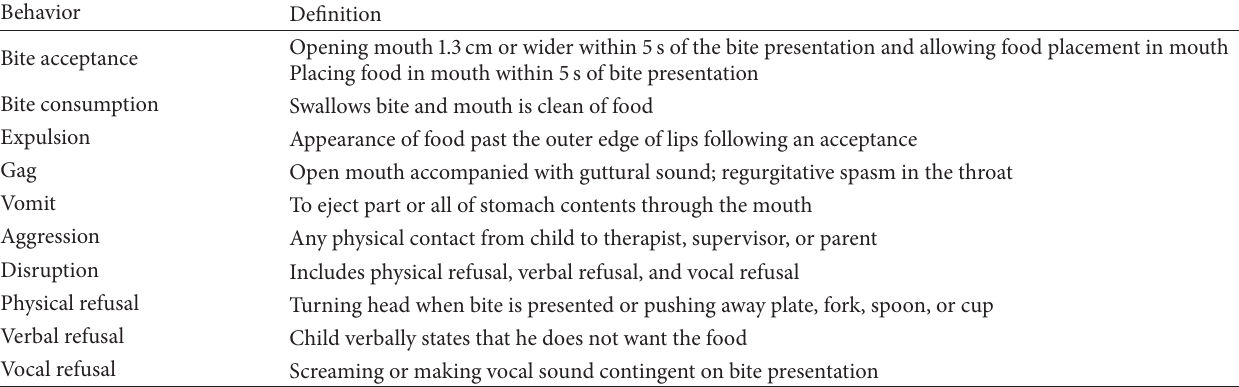
Table 1: Operational definitions of child